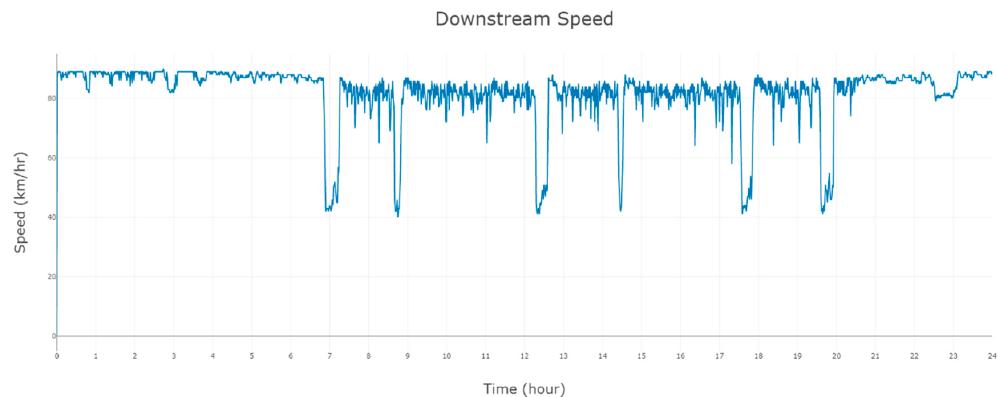
Figure 14. Average speed measured downstream of the ramp—ALINEA metering scenario.